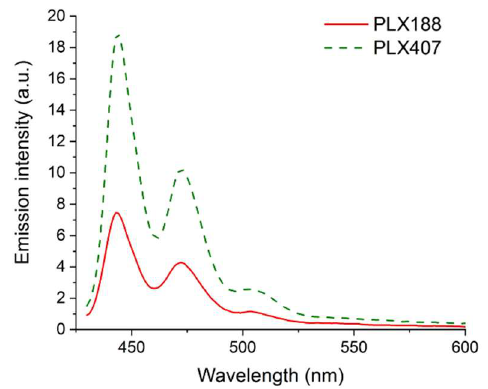
Figure 12. Emission spectra of perylene solubilized by either Poloxamer ® 188 or Poloxamer ® 407 solution (λ ex = 405 nm).